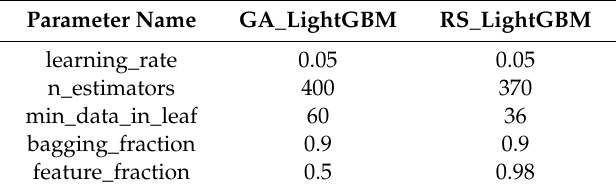
Table 6. Parameters obtained from parameter optimization of genetic algorithm.